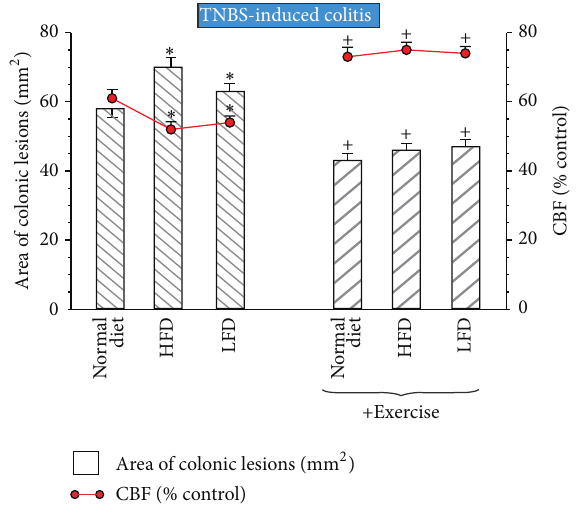
Figure 1: Effect of exercise on the area of colonic lesions and the alterations in CBF in animals fed normal diet, high-fat diet (HFD), and low-fat diet (LFD). Results are mean ± SEM of 8 animals per each group. An asterisk indicates a significant change ( 𝑃 < 0.05 ) as compared to respective values in rats fed normal diet. Cross indi- cates a significant change ( 𝑃 < 0.05 ) as compared to the respective values obtained in animals fed different diets but not subjected to